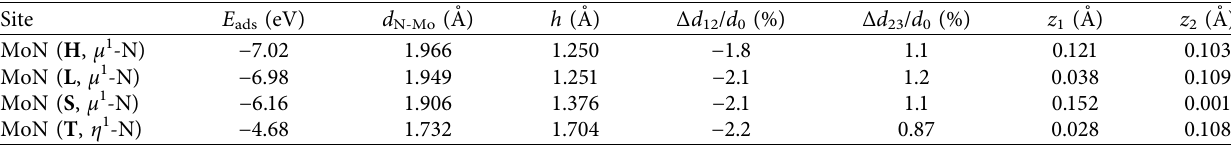
Figure 3: Adsorption structures of N atom on Mo (110) surface (the upper and lower layers are a top view and side view, respectively, the same below). Table 2: Structural parameters of N atoms adsorption on Mo (110) surface.